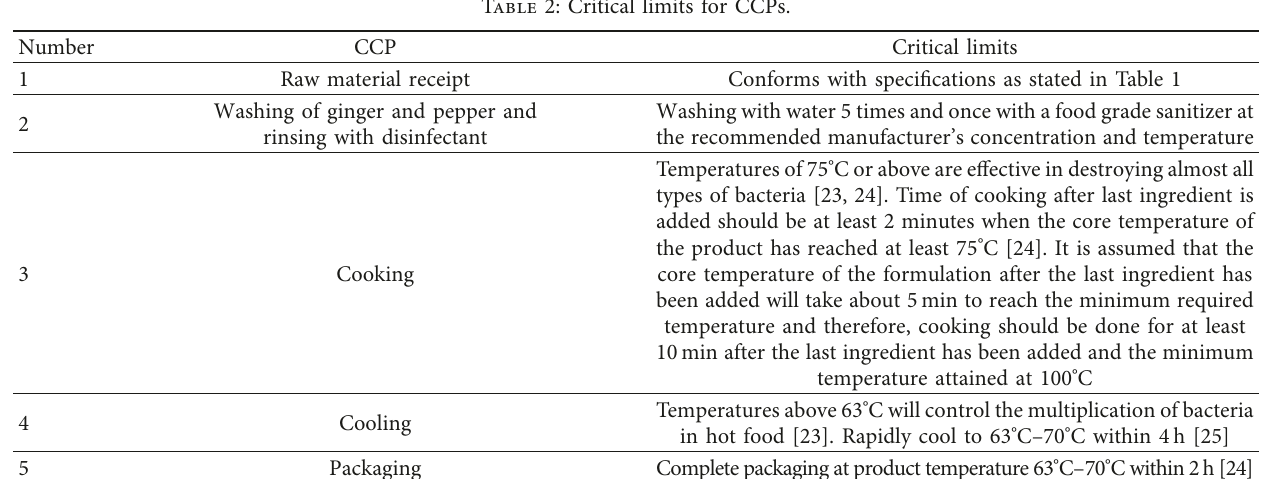
Table 2: Critical limits for CCPs.